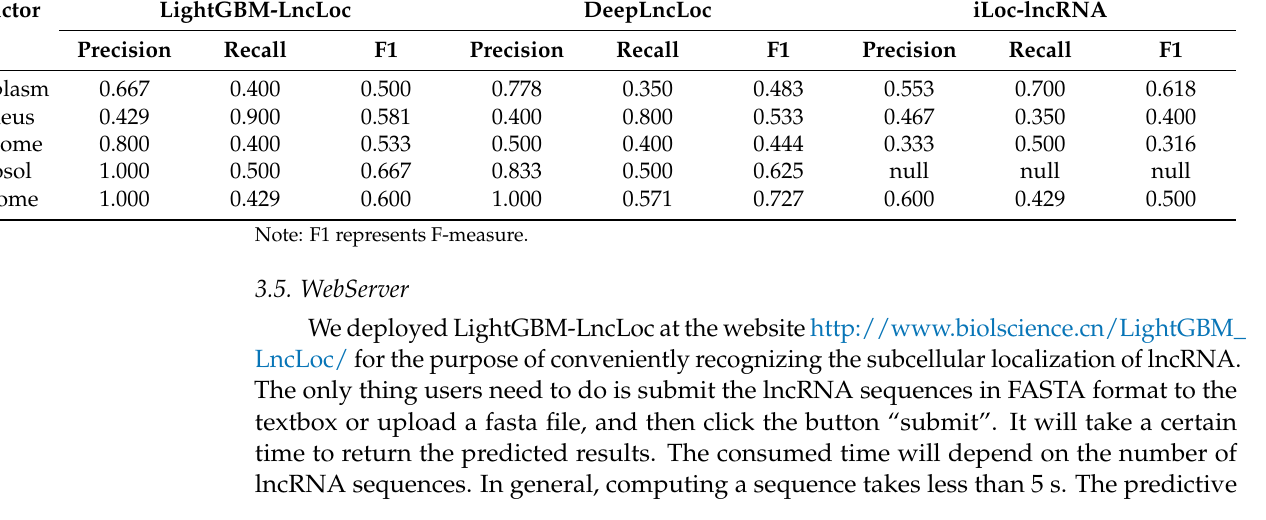
Table 8. Performance for each class on the independent test.